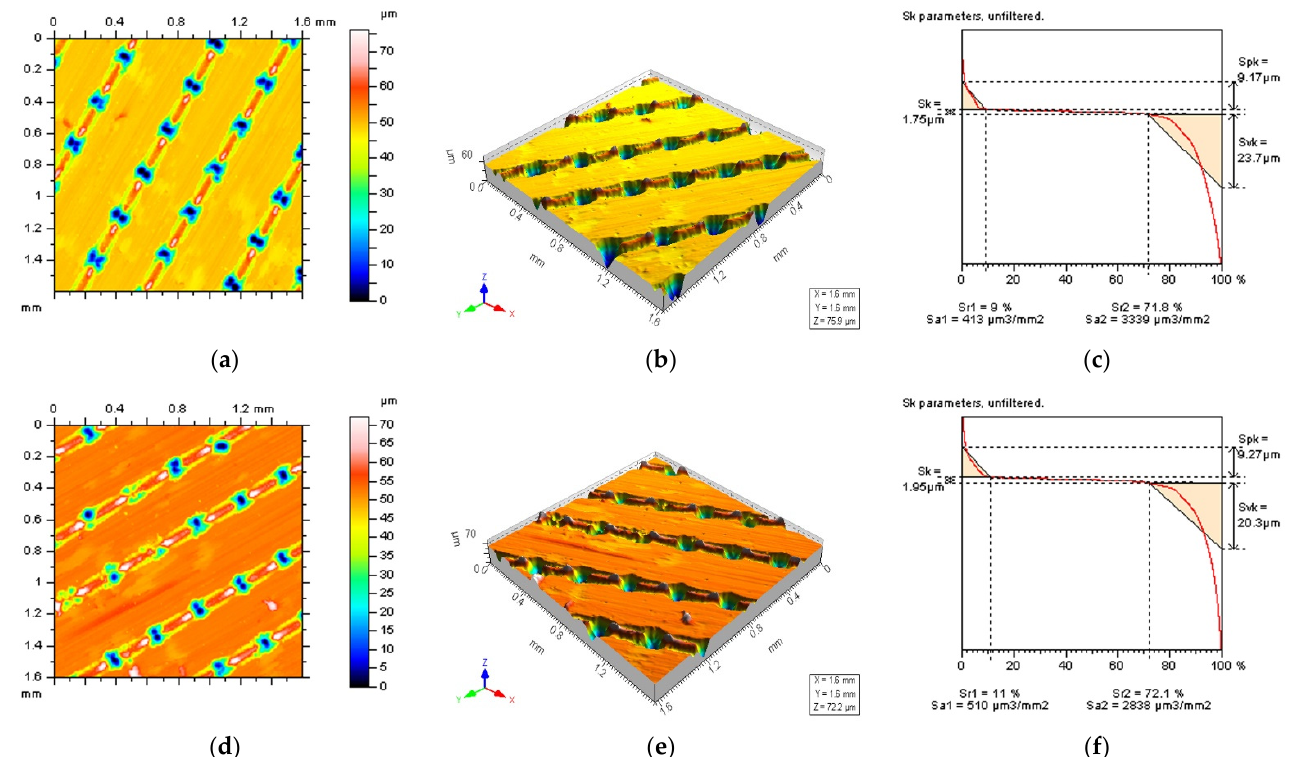
Figure 1. Contour map plots: ( a , d ), isometric views; ( b , e ) and their material ratio curve graphs; ( c , f ) of 30° ( a – c ) and 60° ( d – f ) LST; measured with a stylus